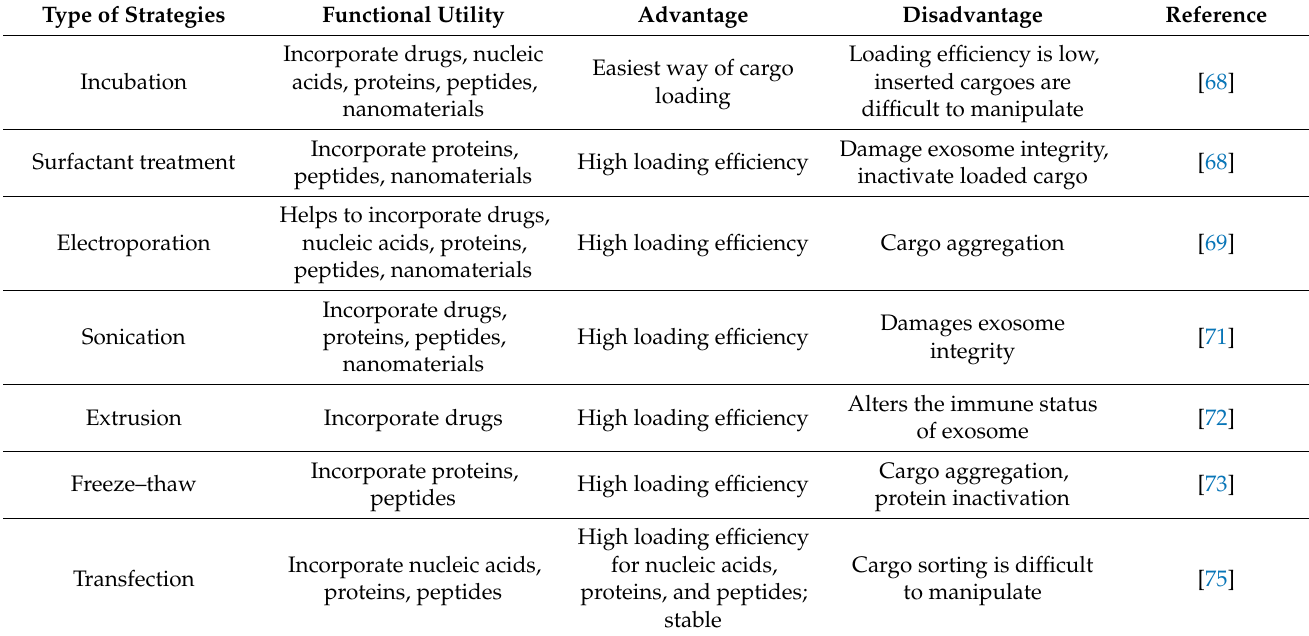
Table 2. Methods of exosomal bioengineering: different strategies used for bioengineering the exosomes and their advantages and disadvantages. Type of